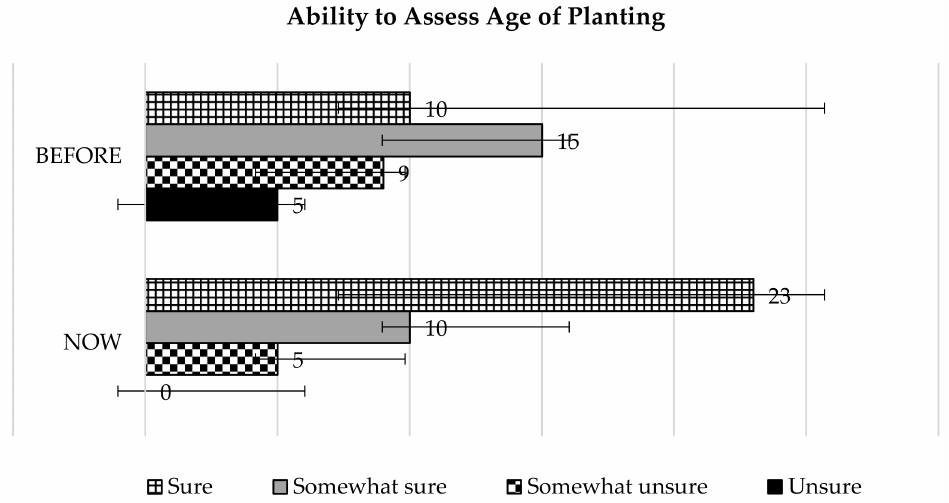
Figure 4. Retrospective self-report on ability to site and design a prairie strip on farmland (n = 39). Legend indicates Likert-style response scale.